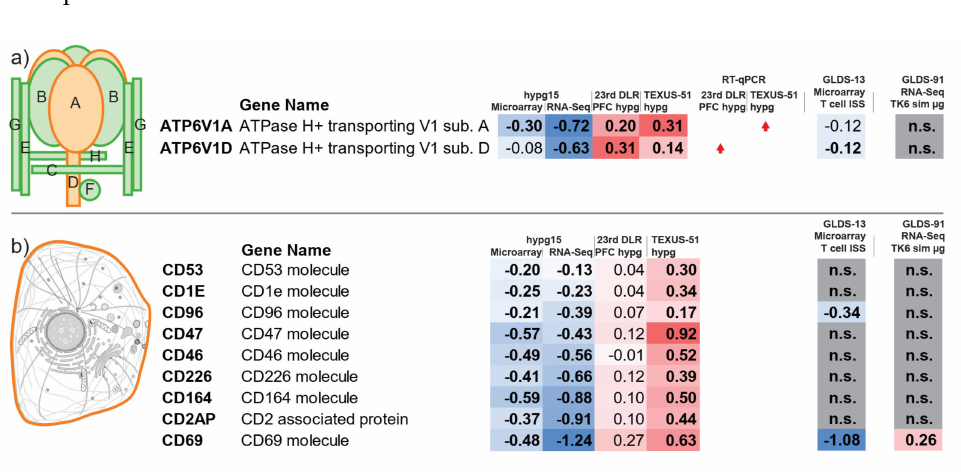
Figure 10. Highlighted groups of protein-coding genes have been analyzed for their behavior in different experiments separately. ( a ) ATP6V1 is the catalytic subcomplex of the ATP6V ion pump. The proteins ATP6V1A and ATP6V1D are known to be robustly affected by hypergravity. In the 23rd DLR PFC data set and the TEXUS-51 data set, they are upregulated under hypergravity, demonstrated by microarray data and independent RT-qPCR. Here, the fold changes for the hypg15 microarray and RNA-Seq data sets and the 23rd DLR PFC and the TEXUS-51 data sets are shown. Significant differential expressing genes (FDR < 0.05) are highlighted in bold. Two long-term external microgravity studies on immune cells were included (NASA GeneLab GLDS-13, 1.5 h microgravity onboard the ISS on activated human T cells, microarray data; NASA GeneLab GLDS-91, 48 h simulated microgravity (sim- µ g) on TK6 immune cells, RNA-Seq) and the respective fold changes listed if significant (FDR < 0.05). ( b ) CD69 is among the strongest reacting genes for the hypg15 data sets. Here, all CD genes that are significantly differentially expressed (FDR < 0.05) in both hypg15 data sets are listed, including their fold changes in the microarray and RNA-Seq data set. Except for CD2AP and CD1E, all localize on the cell membrane, as indicated by the orange line. Two long-term external microgravity studies on immune cells were included (GLDS-13, 1.5 h microgravity onboard the ISS on activated human T cells, microarray data; GLDS-91, 48 h sim- µ g on TK6 immune cells, RNA-Seq) and the respective fold changes listed if significant (FDR < 0.05). Table 1. Internal and external hyper- and microgravity data sets from different platforms measured by different transcrip- tomics techniques that were used for cross-correlation analysis of selected highly validated groups.